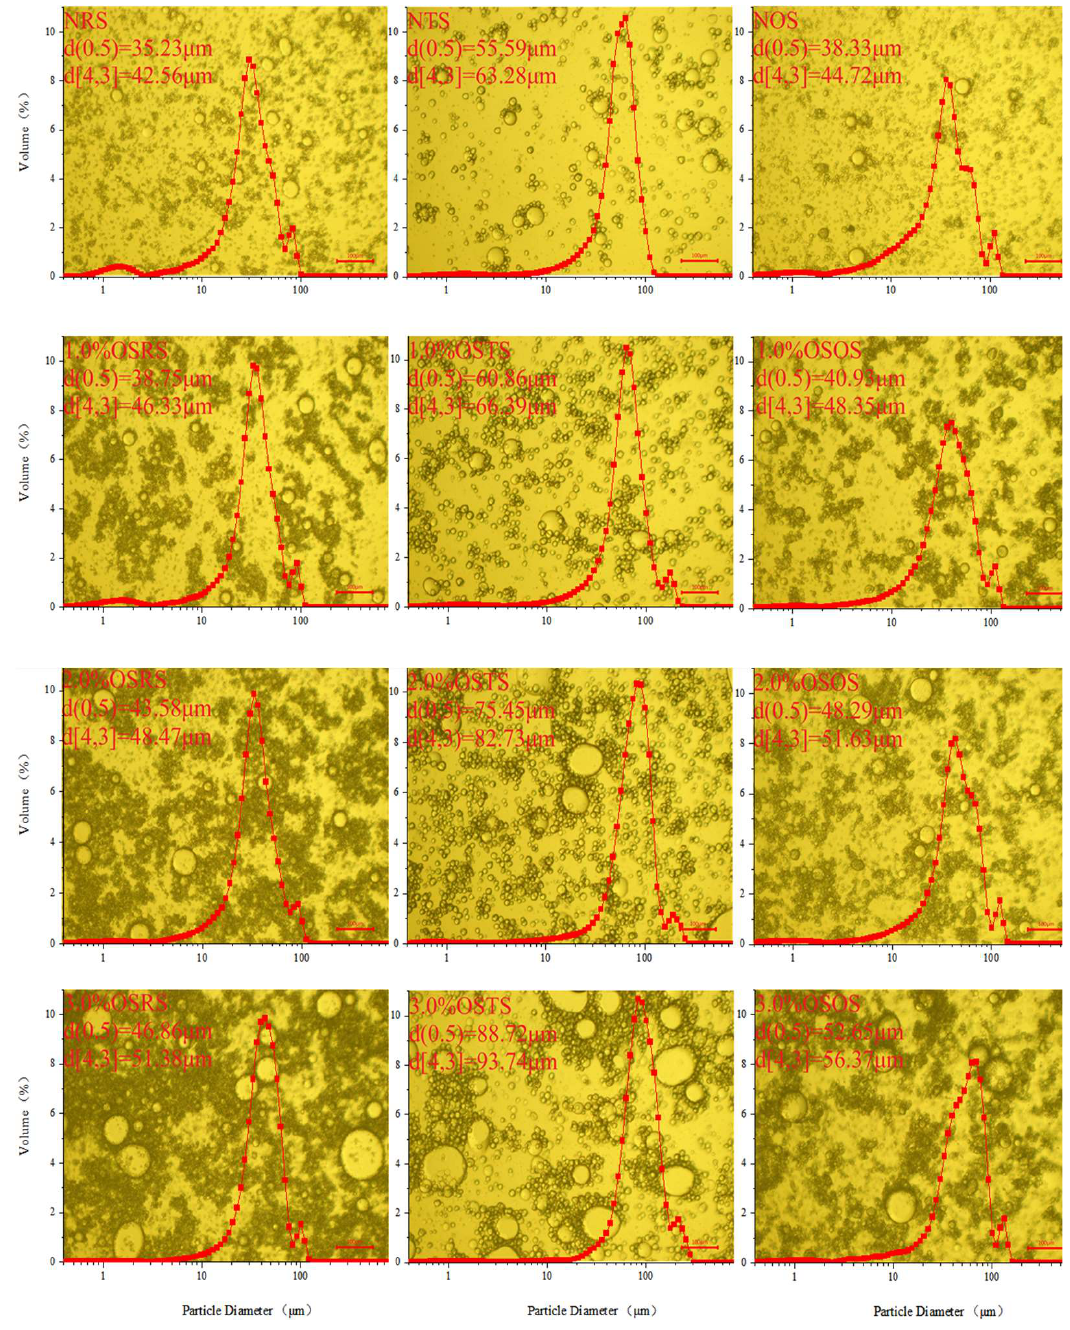
Figure 8. PLM and DSD of Pickering emulsions prepared by NS and OS-starch. Comparisons made with different NS and OS-starch showed that the smallest d(0.5) and d[4,3] of Pickering emulsion droplets were prepared from NRS and OSRS, followed by NOS and OSOS, and the relatively largest d(0.5) and d[4,3] were prepared from